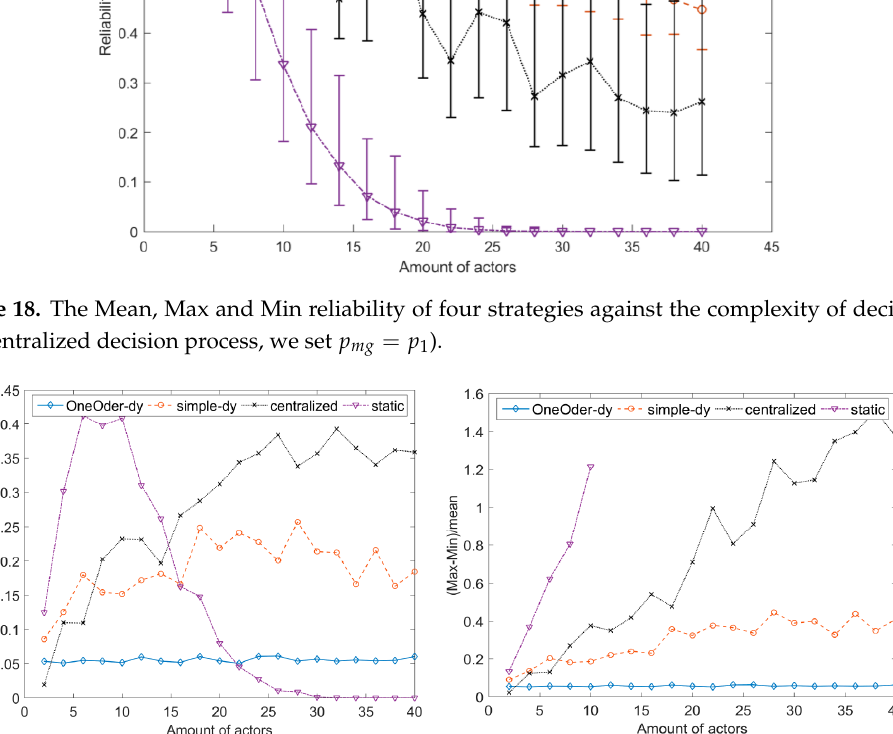
Figure 19. Stability of reliability under random failure and process time (As the curve of static process increase much faster than other strategies, it just has the first 5 points in Figure 19b). ( a ) Max−Min of the reliability; ( b ) (Max−Min)/Mean.